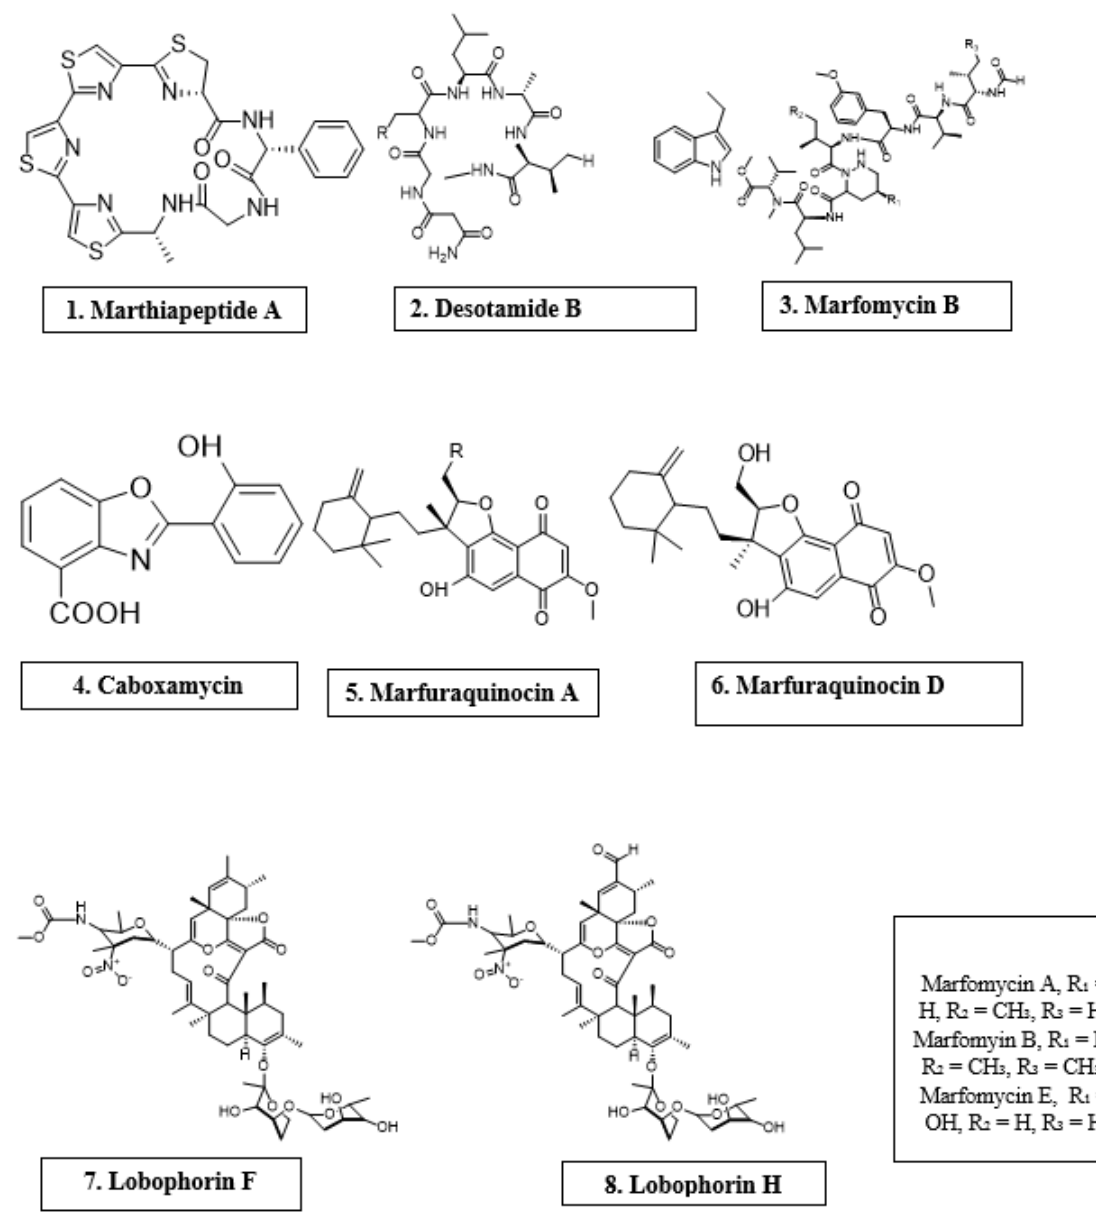
Figure 1. Antimicrobial compounds of different classes isolated from